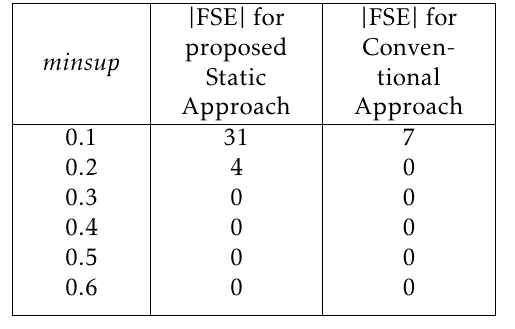
Table 15. Number of frequent singleton edges (|FSE|) for paths data for proposed static approach compared to Conventional approach